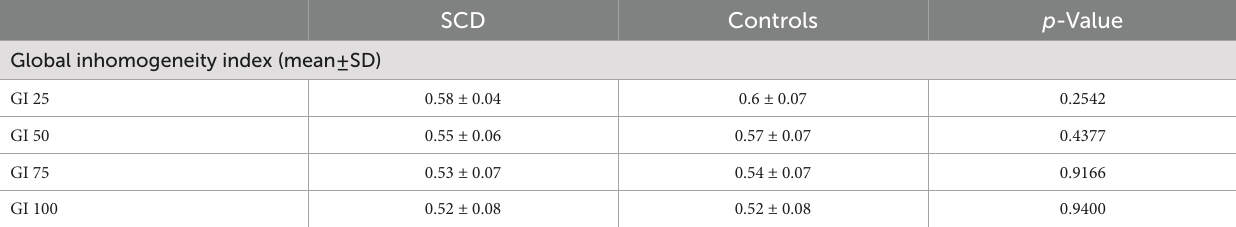
TABLE 4 Global inhomogeneity index of SCD patients ( n = 16) and controls ( n = 26) at the level of 25, 50, 75 and 100% inspiratory